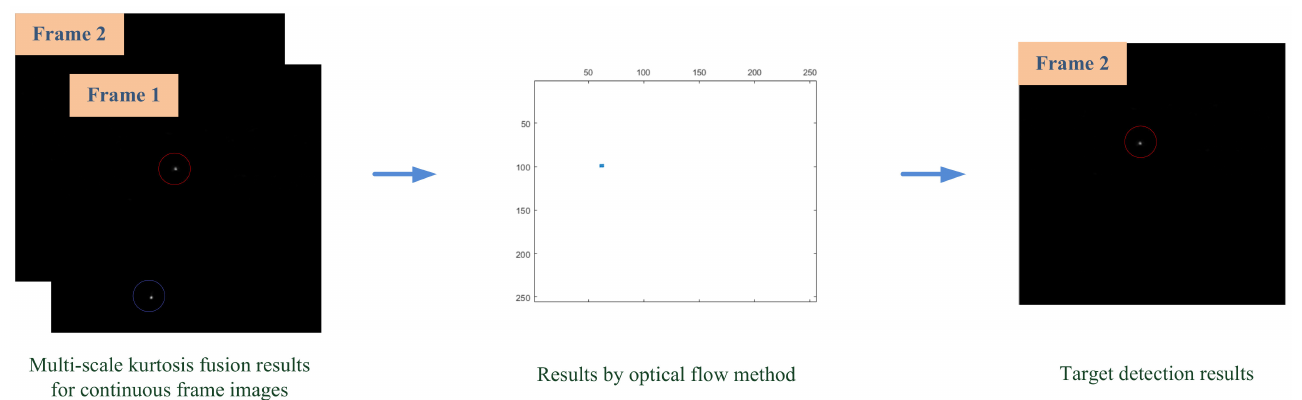
Figure 8. Target detection with the optical flow method for the output image sequence of kurtosis map